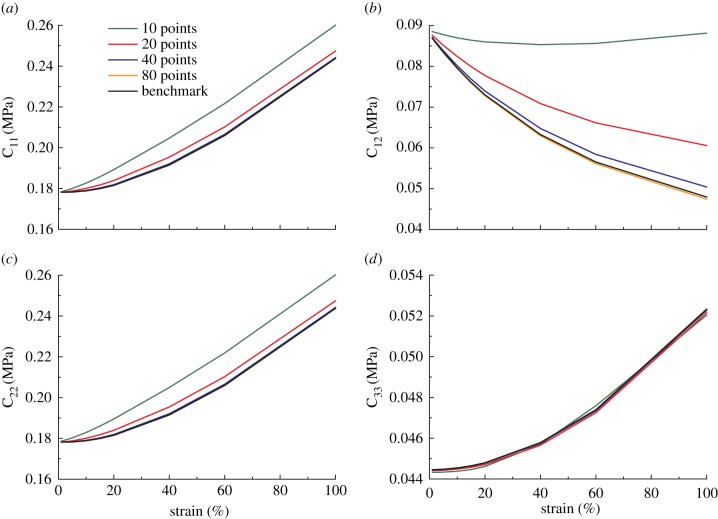
Convergence results towards the solutions from the traditional PBC method when the number of control points is increased. (a–d) show the results for the components C11, C12, C22 and C33, respectively. (Online version in colour.)